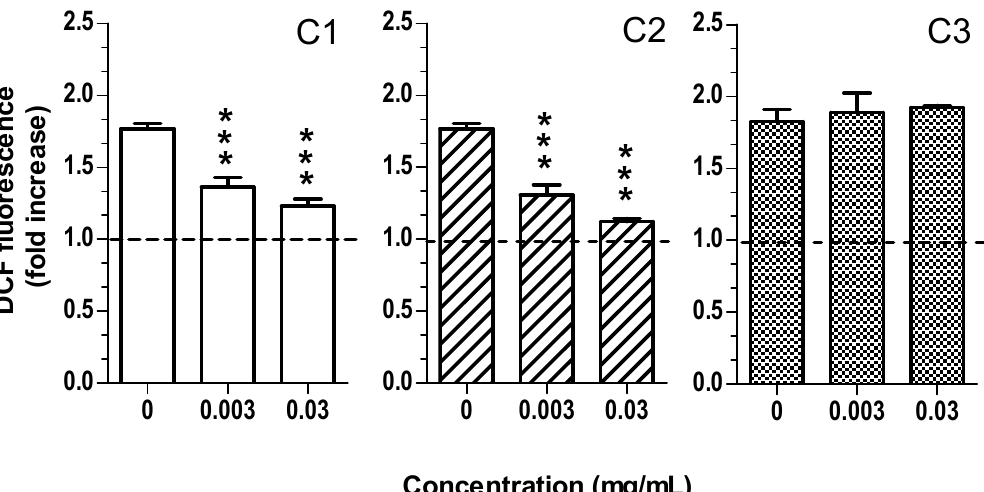
Figure 4. C1 and C2, but not C3, extracts reduce oxidative stress induced by H 2 O 2 in HaCaT cells. Cells were treated with various concentrations of extract (0.003–0.03 mg/mL) for 2 h and then treated with H 2 O 2 (100 µM) for 30 min. At the end of treatment, intracellular oxidative stress was evaluated using the probe DCFH 2 -DA, as described in the method section. Data are expressed as fold increase of fluorescent DCF formation versus untreated cells and reported as mean ± SEM of three independent experiments (*** p < 0.001 vs. cells treated with H 2 O 2 ; one-way ANOVA with Dunnett post hoc test).